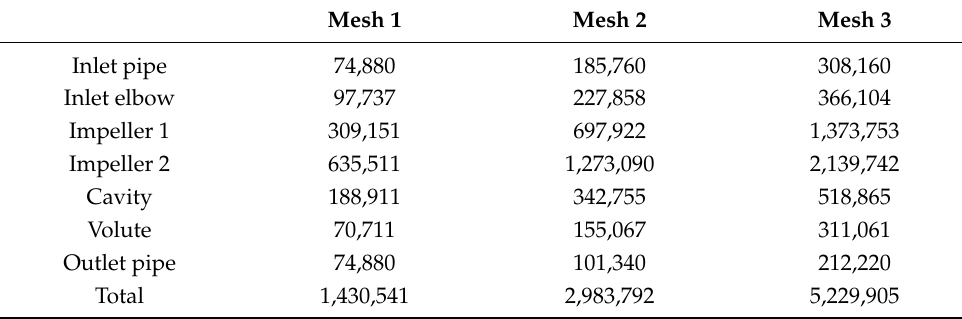
Table 4. Details of three mesh sets used for mesh sensitivity